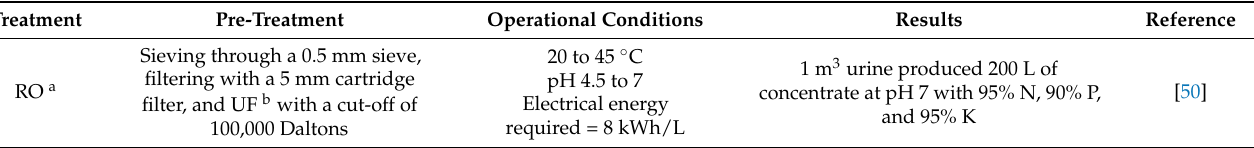
Table 1. Treatment methods for human